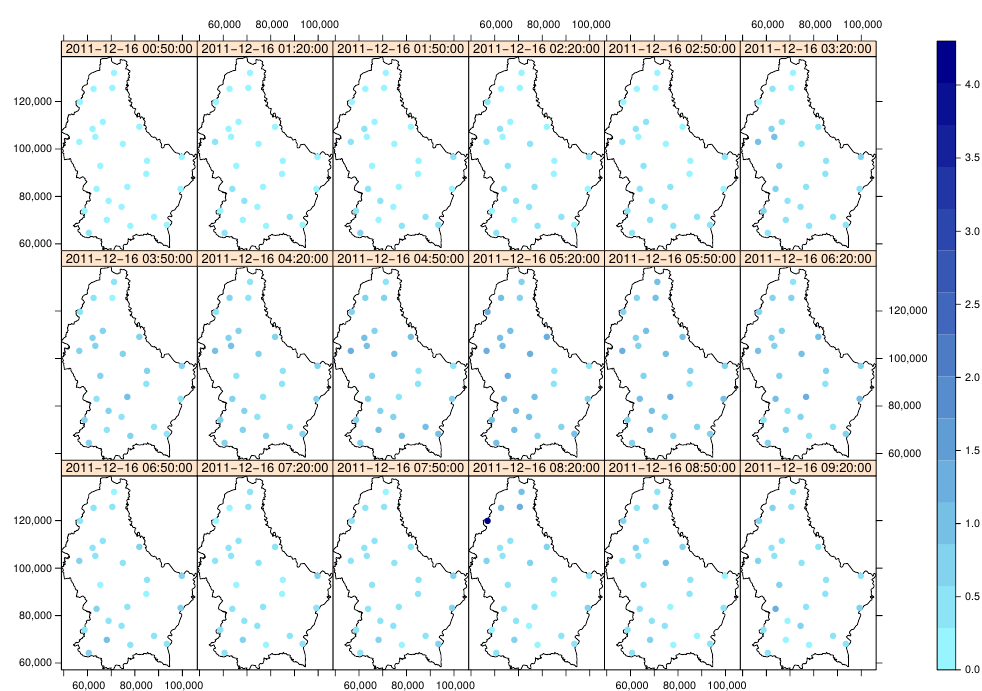
Figure 6. Distribution of observations for event 16 December 2011 over the country of the Grand-Duchy of Luxembourg, 18 snapshots for illustration purpose only. Every dot represents a rain gauge observation. The units of the x and y scales are meters. The scale bar represents precipitation in